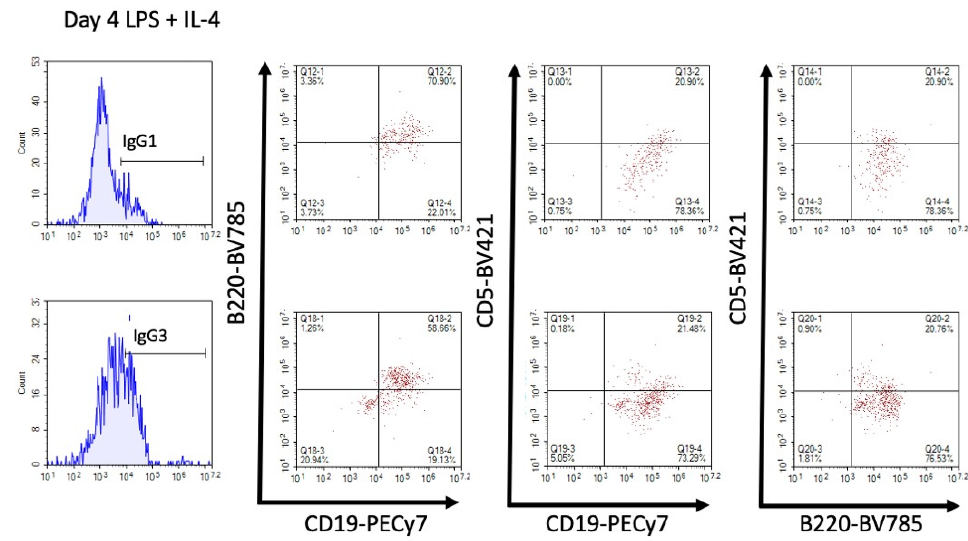
Figure 7. CD19 and B220 were highly co-expressed. Using LPS + IL-4-stimulated SPLC from day 4, cells were pre-gated for total IgG1 or IgG3 from the live single lymphocyte population then assessed for CD19, B220 and CD5. Top, IgG1; bottom, IgG3. Data from one of the LPS + IL-4 samples of one of at least two experiments are representative.